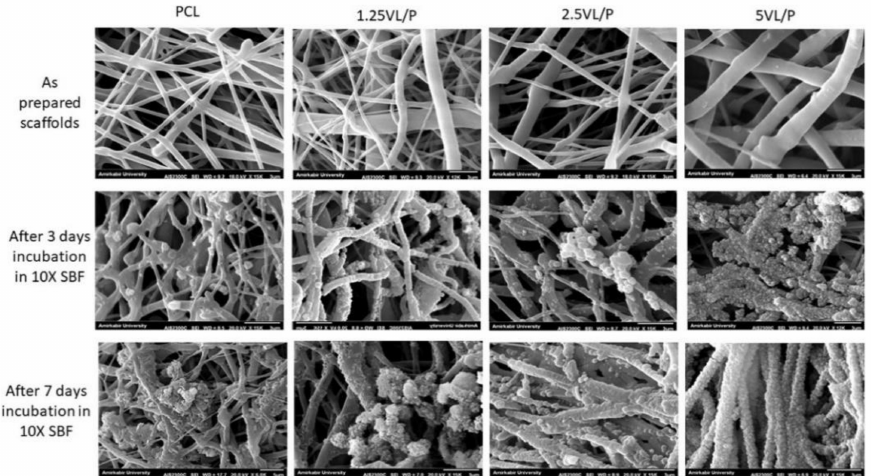
Figure 3. Scanning electron microscope images of as-prepared scaffolds and after 3 and 7 days incubation in 10 × SBF. The formation of spherical apatite-like crystals increased significantly after adding nanohybrids to the scaffolds. For the legends, pure PCL and VD3 · LDH/PCL electrospun scaffolds containing 1.25, 2.5, and 5 wt% of vitamin D3 are presented as PCL, 1.25VL/P, 2.5VL/P,